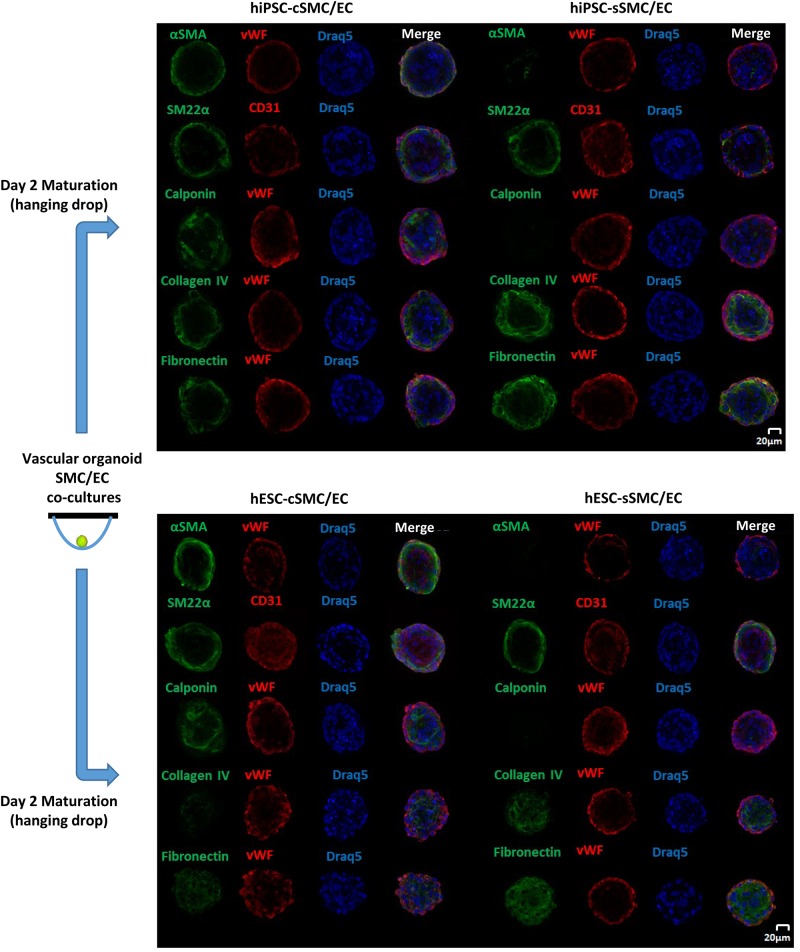
Generation and Immunophenotypic characterization of vascular organoids. Vascular organoids were generated in 2 days using the hanging drop method (illustration). Immunofluoresence analysis was performed on vascular organoids consisting of hiPSC-cSMC/EC, hiPSC-sSMC/EC (upper panel) and hESC-cSMC/EC, hESC-sSMC/EC (lower panel). Green fluorescence indicates either SMCs expressing αSMA (1st line), SM22α (2nd line), Calponin (3rd line), Collagen IV expression (4th line), and Fibronectin expression (5th line) whereas red indicates ECs (von Willebrand or CD31 staining) and blue indicate nuclei (Draq5 staining). Images were taken on Leica TCS SP5 confocal microscope and are representative of at least three independent experiments. Scale bar, 20 μm.